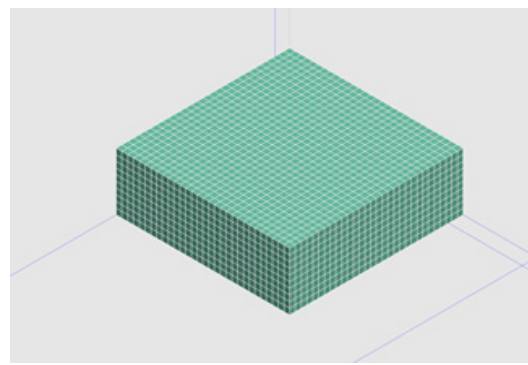
Figure 2. Geometric model of geometry for the calculation of infiltration on a drainage asphalt Figure2. pavement.